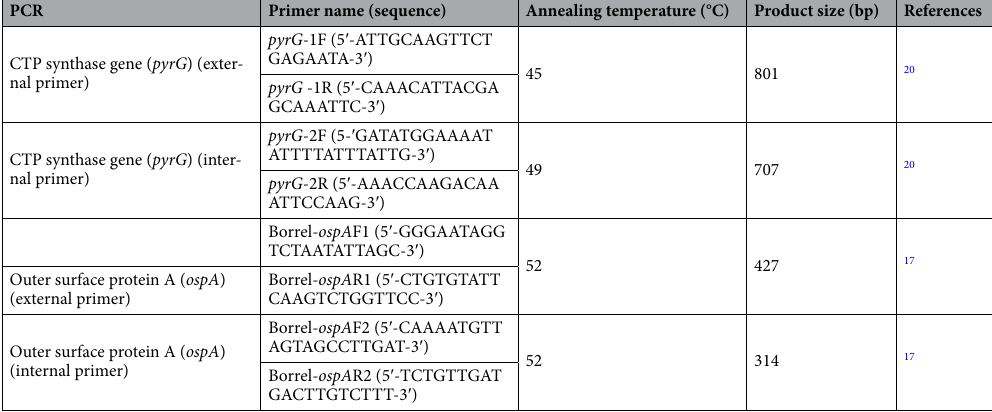
Table 4. Oligonucleotide primers and PCR conditions used in this study † . † bp, base pair; PCR, polymerase chain